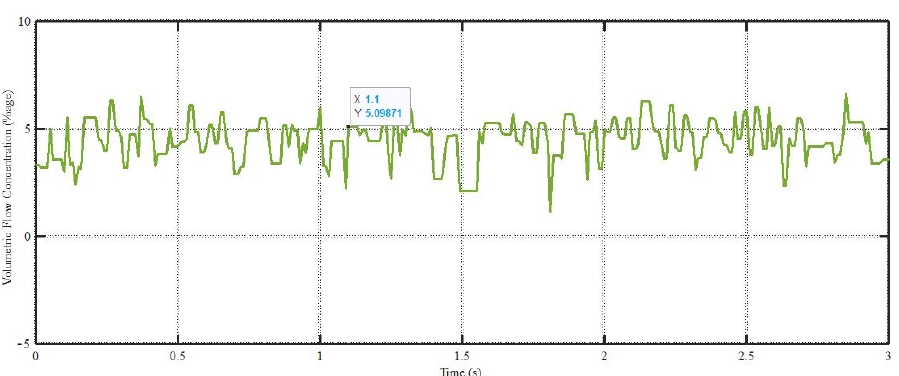
Figure 15. Volumetric flow concentration of sand particles using an electric